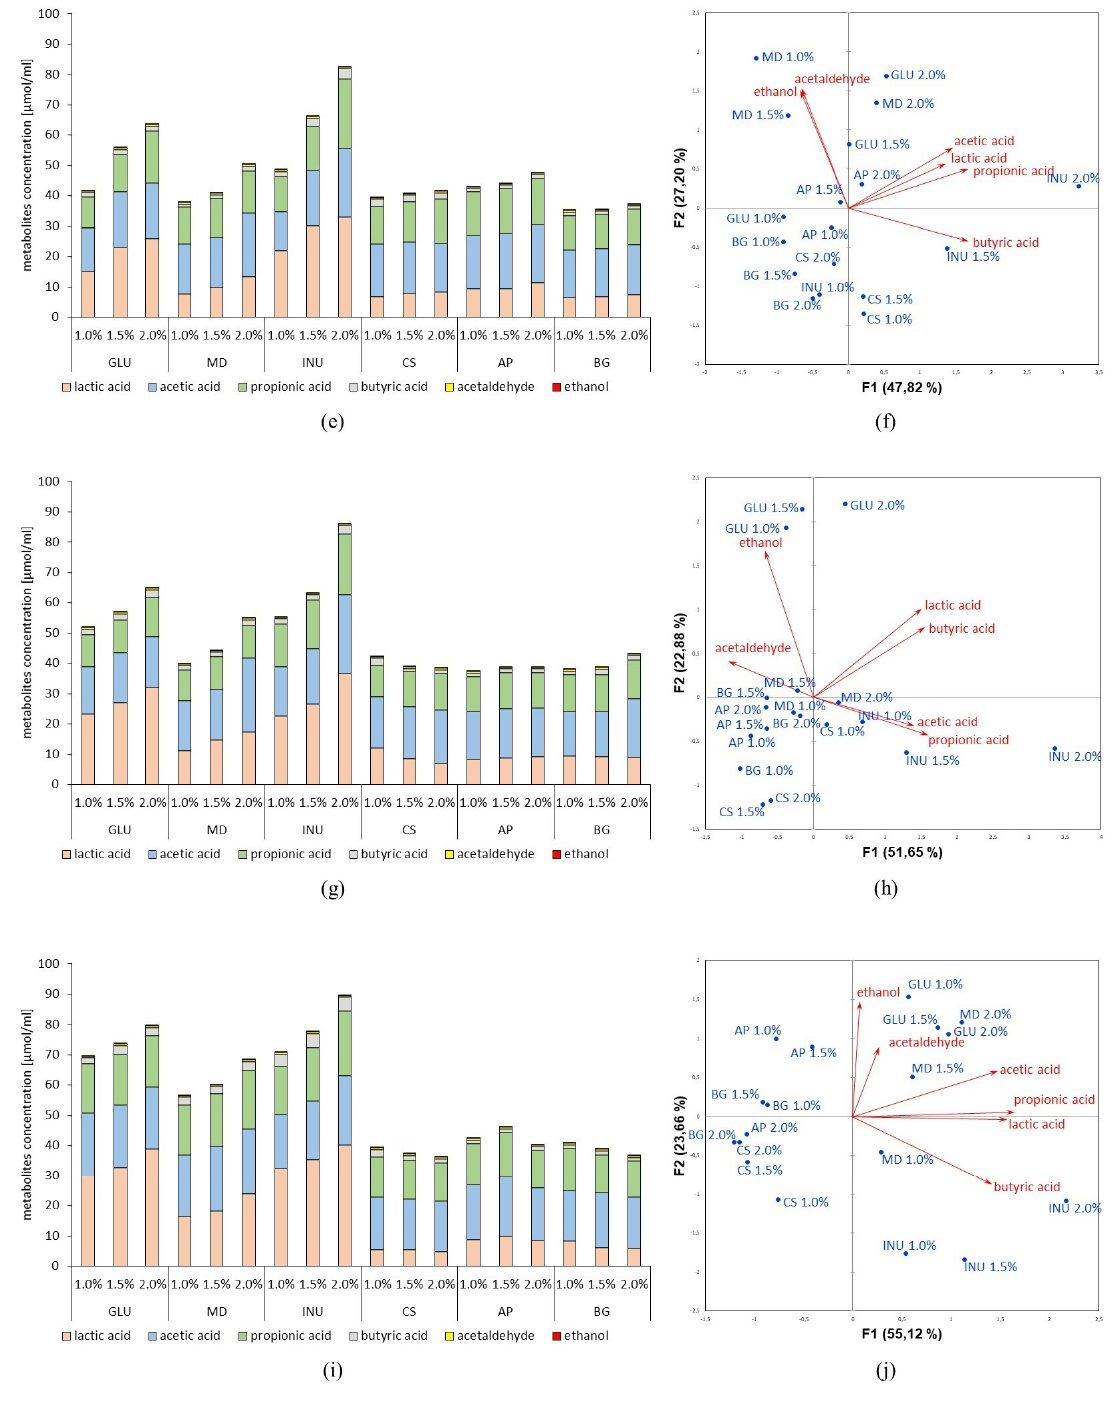
Figure 1. Metabolites concentration produced by probiotic strains, namely, ( a ) Lb. rhamnosus ŁOCK 1087, ( c ) Lb. paracasei ŁOCK 1091, ( e ) Lb. reuteri ŁOCK 1092, ( g ) Lb. plantarum ŁOCK 0860, and (i) Lb.